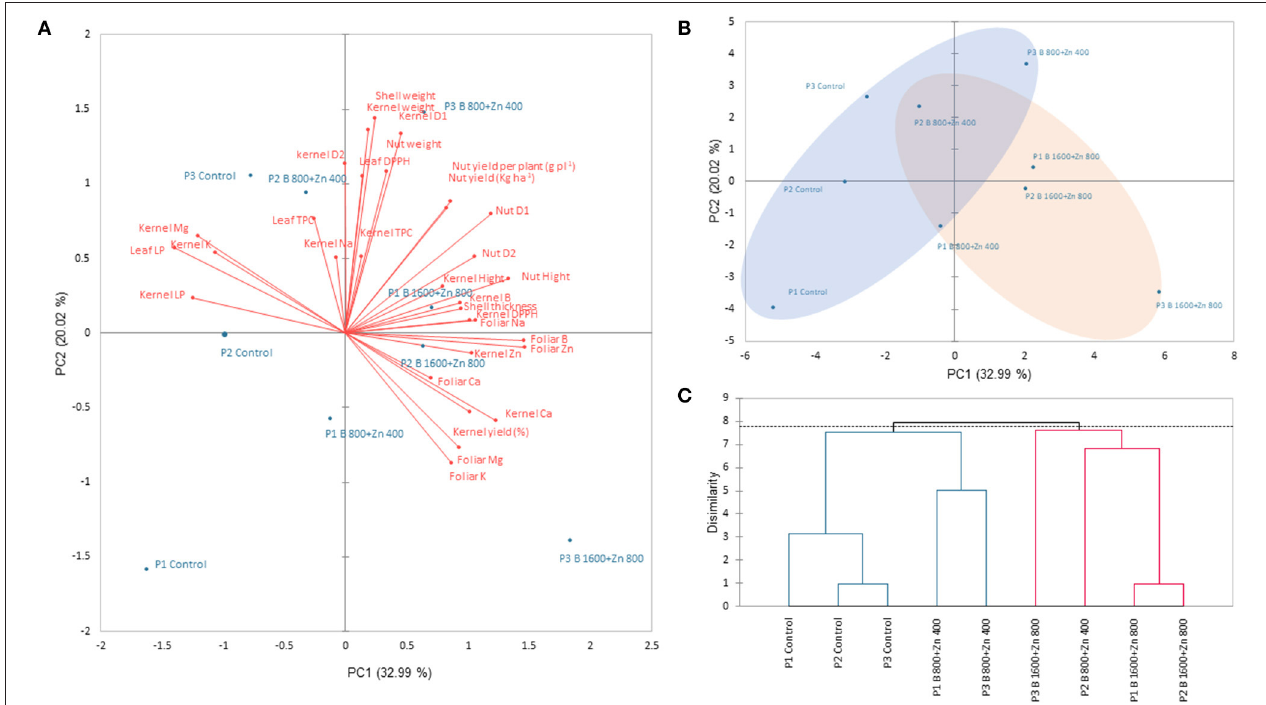
FIGURE 8 | Principal component analysis (PCA) based on Pearson’s correlation. Numbers in parentheses give the percent of the total variation explained by the PC1 and PC2, both representing 51.01% of the total variance. (A) Biplot of correlation, showing the treatments and variables together. (B) Principal component score plot. Treatments are clustered in two groups represented as blue and red ellipses. (C) Agglomerative hierarchical clustering (AHC) based on dissimilarity. The dotted line represents the automatic truncation, leading to two groups, which are represented in (A) by blue and red